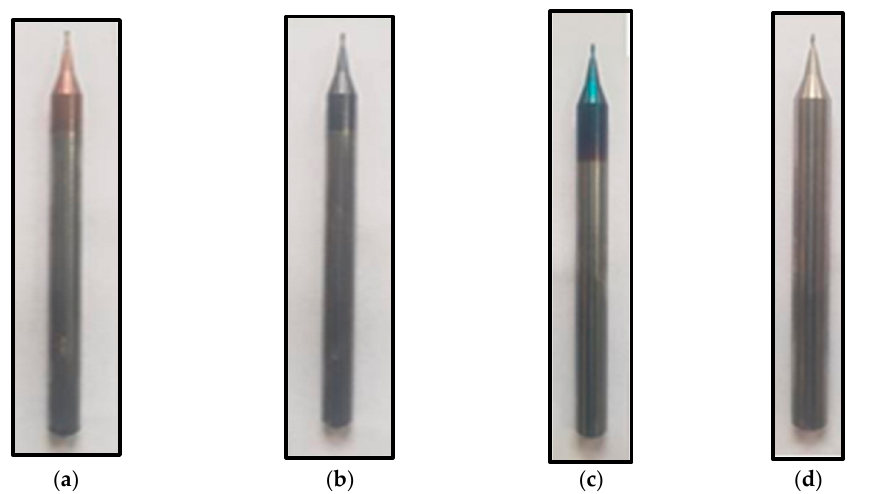
Figure 1. Different tools used in the current study ( a ) TiSiN, ( b ) AlTiN, ( c ) nACo, ( d ) un-coated.